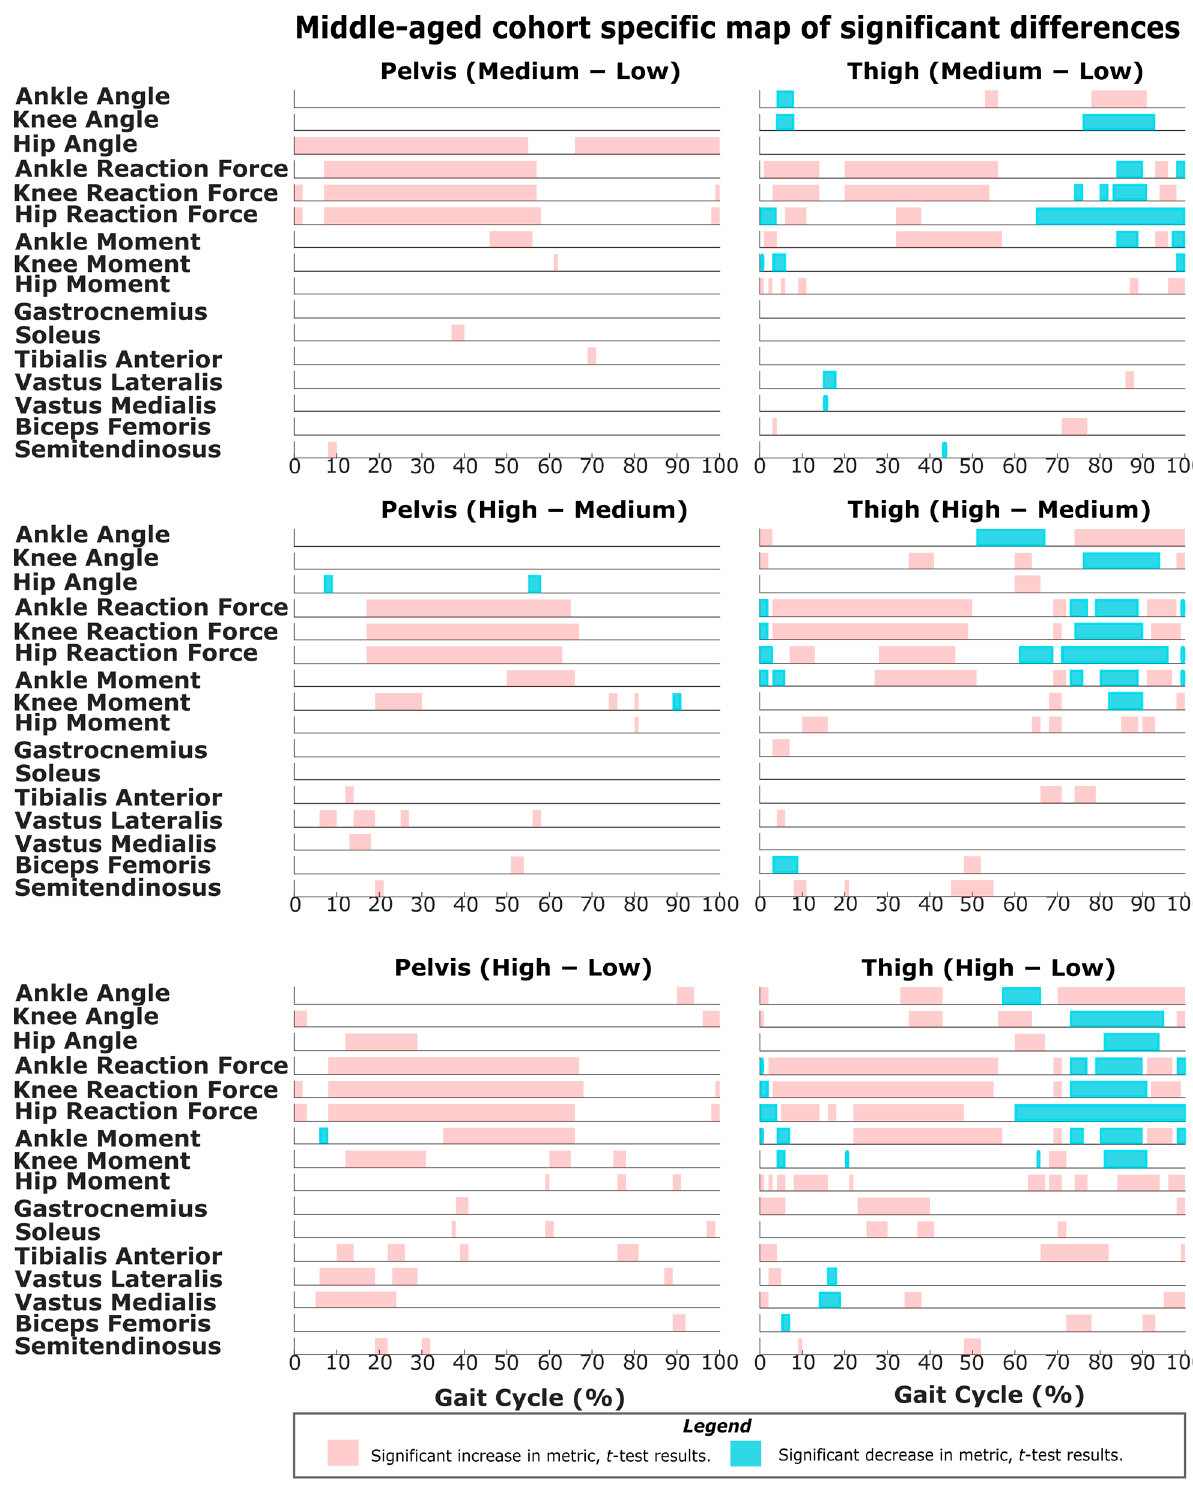
Figure 4. Map of all the SPM results for middle-aged adults. Column 1 contains the results from the t -test for a full-factorial comparison of the pelvis masses. Column 2 contains the results from the t -test for a full-factorial comparison of the thigh masses. An increase in the metric (higher weight causes more ‘+’ve change) is highlighted in red, and a decrease in the metric (higher weight causes more ‘ − ’ve change) is highlighted in blue. Results from row 3 are also represented in Figures 6, 8 and 10 to indicate regions of significant differences.